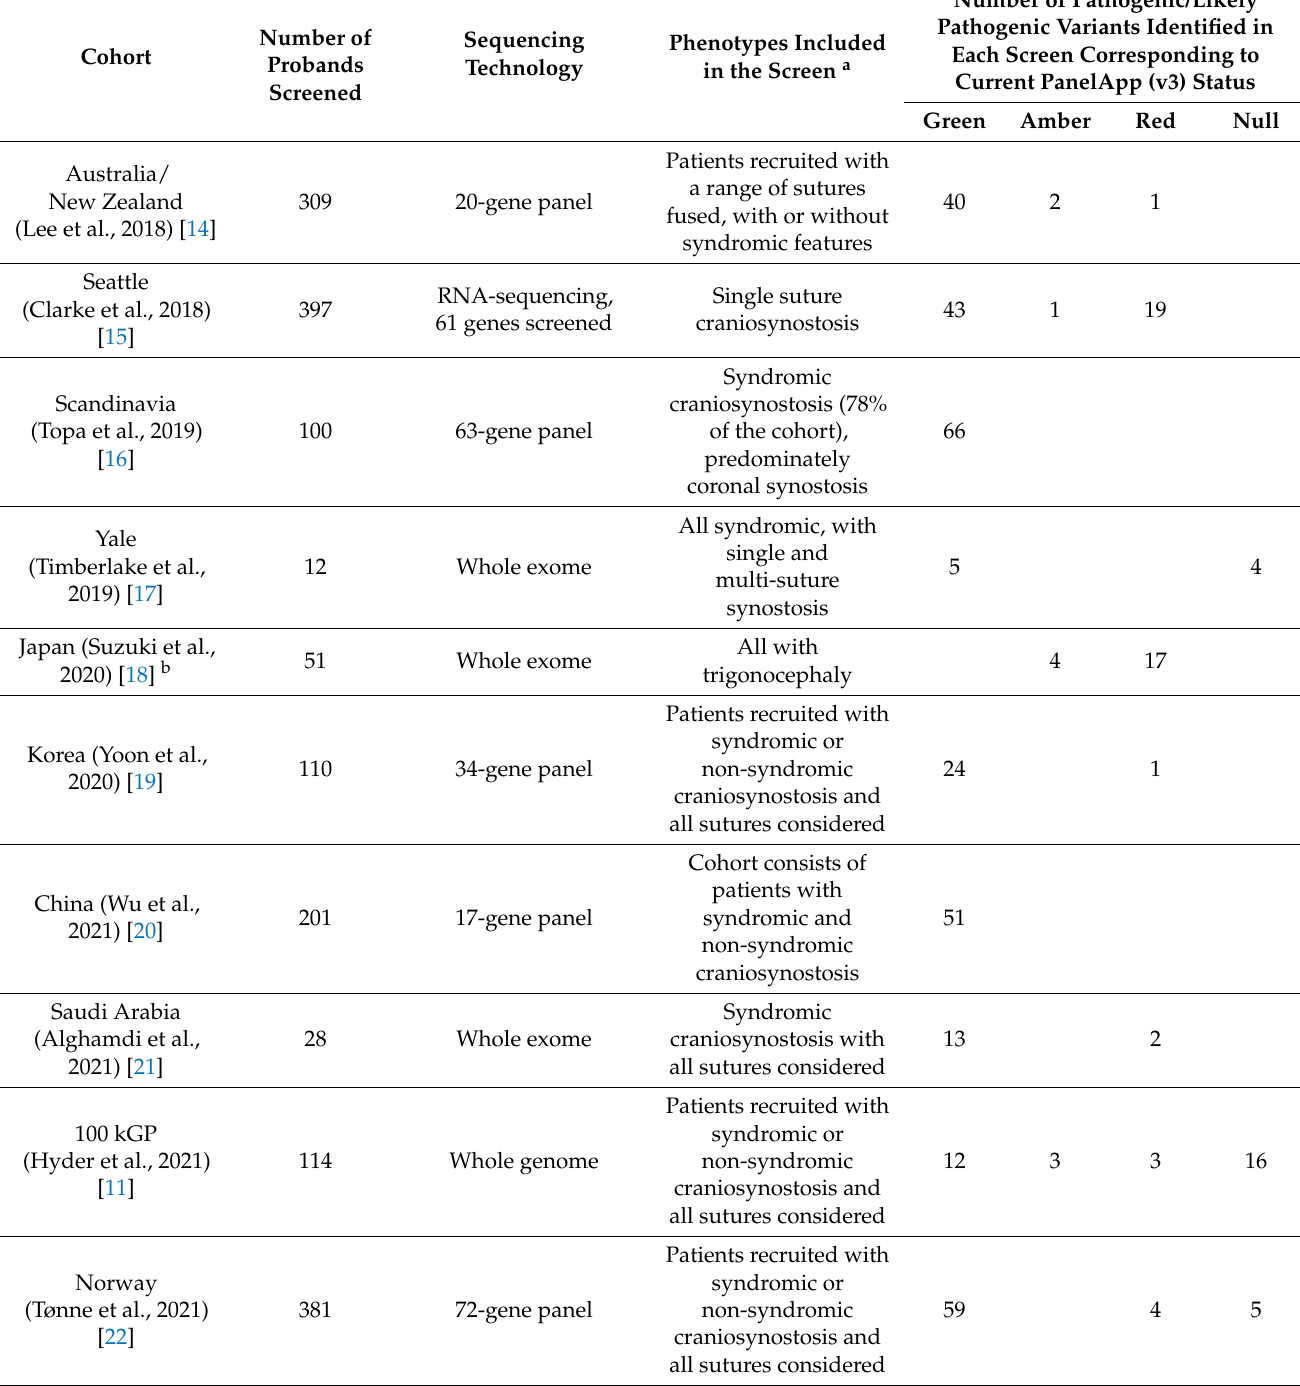
Table 1. Sequencing of cohorts of patients with craniosynostosis from